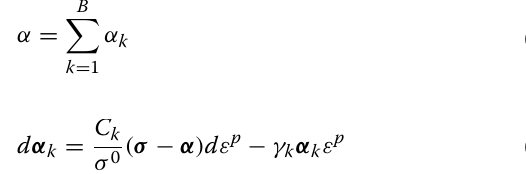
Fig. 16. The configuration of such brace was first proposed by Taiyari et al. [39]. The brace employed USSs as its kernel energy-dissipative elements. The brace components include the outer tube, the Z-shaped inner plate, end-plate, con- nection plate and tightening nuts. On one side of the brace, the connection plate was welded to the end-plate, while the end-plate was further welded to the Z-shaped inner plate. On the other side of the brace, another connection plate was welded to the outer tube. Bolt-holes were reserved in the connection angles and connection plate. During assembly, one of the straight segments of the USS is first connected to the Z-shaped inner plate, by either fillet welding or bolting, and the other straight seg- ment is connected to the outer tube. The entire assembly process can be prefabricated in the workshop. The brace is finally connected to the main frame by connection plates.